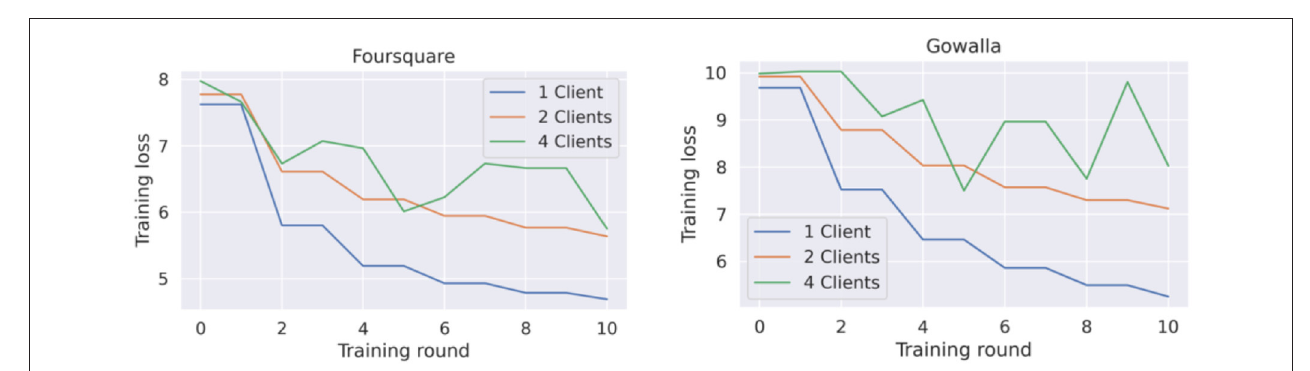
FIGURE 7 | Training loss for federated flashback model with 1, 2, and 4 clients.